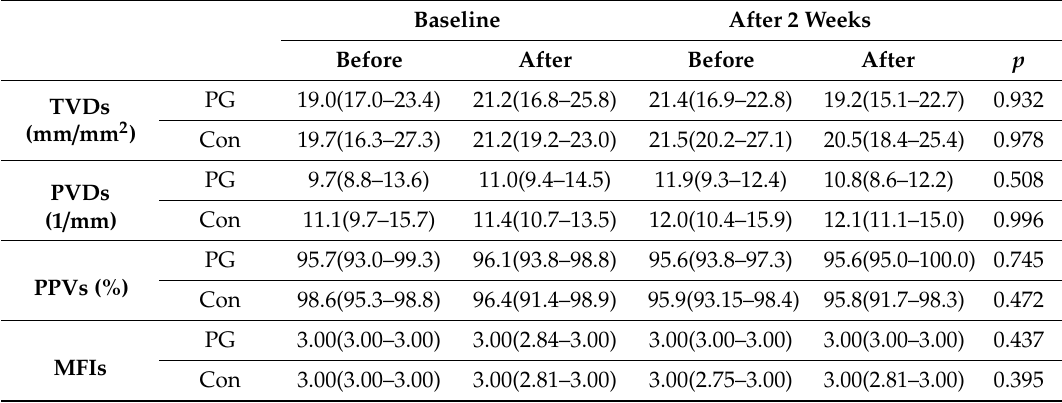
Table 3. Changes in microcirculatory parameters during the study